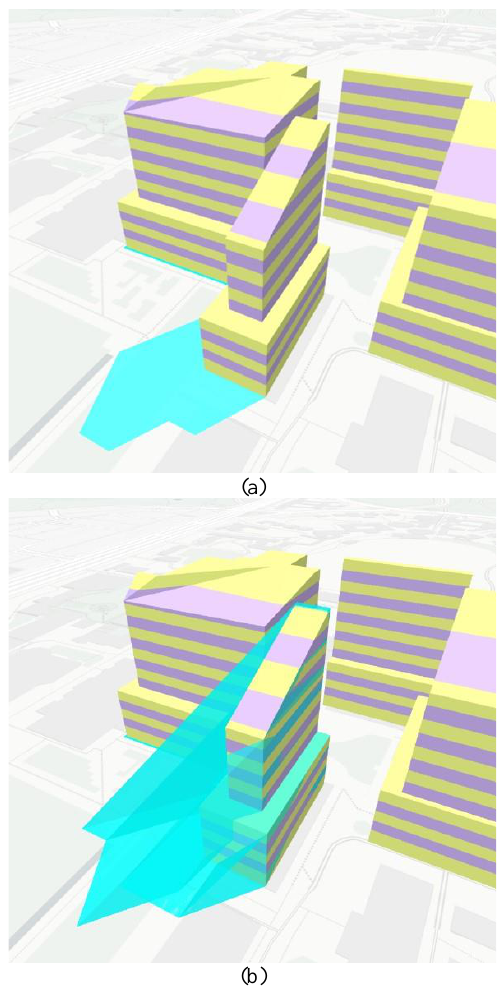
Figure 6. 2D (a) and 3D (b) time-series shadow analysis results and